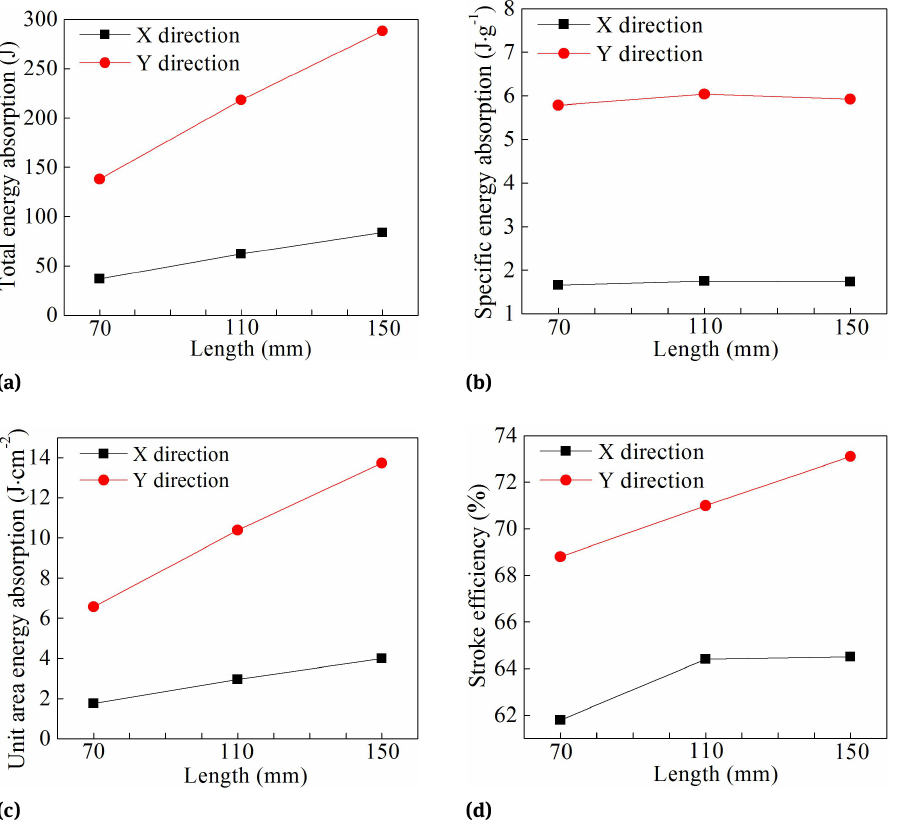
Figure 16: Effects of tube lengths of regular pentagon paper corrugation tube on cushioning energy absorption parameters: (a) total energy absorption; (b) specific energy absorption; (c) unit area energy absorption; (d) stroke